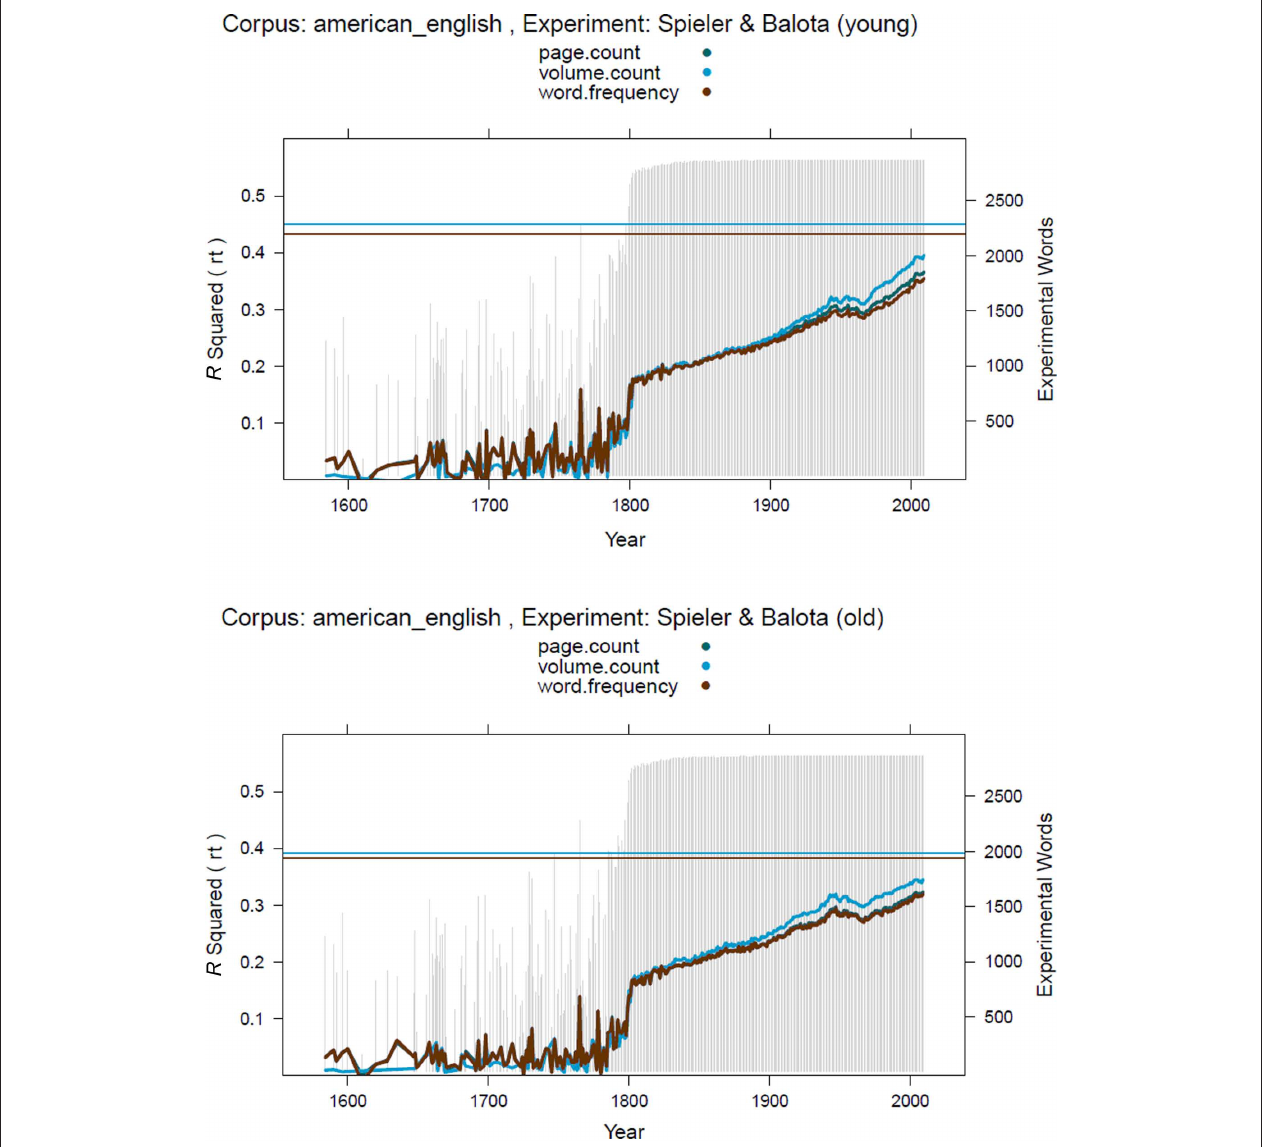
FiGURE 4 | Percentages of variance explained by the Google American English ngrams in the lexical decision latencies of Spieler and Balota. Top: data for the young participants; Bottom: data for the old participants. Horizontal lines: Percentages of variance explained by SUBTLEX-US. The patterns are similar for the English Fiction